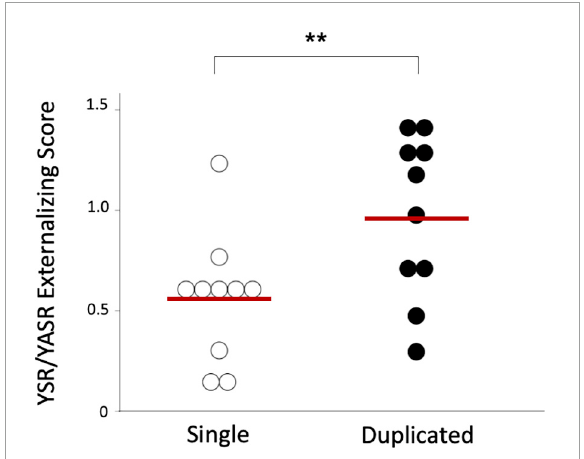
FIGURE3 Youth Self-Report (YSR) or Young Adult Self-Report (YASR) externalizing scores in the borderline personality disorder patients with single and duplicated Heschl’s gyrus patterns on the left hemisphere. Horizontal bars indicate means of each group. * p < 0.05.